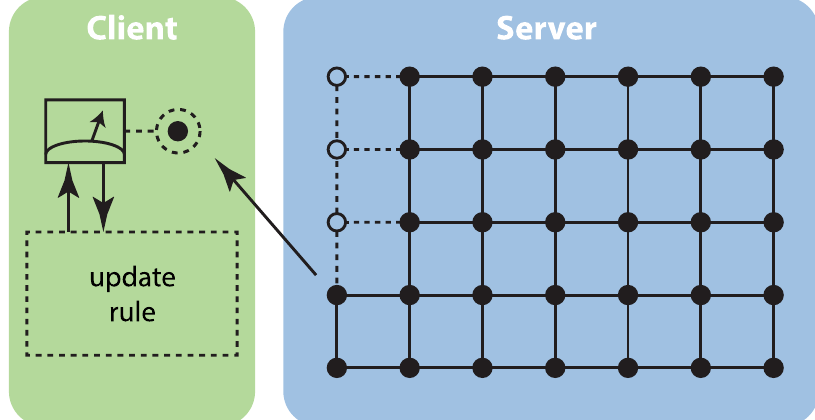
Fig. 6 A depiction of the BQC approach considered by Morimae and Fujii, 11 in which the client performs adaptive measurements on a sequence of qubits sent to them by the server. By having the server send the client a universal resource state one qubit at a time, the client can implement an arbitrary computation without ever sending information to the server beyond the initial graph description (Fig.